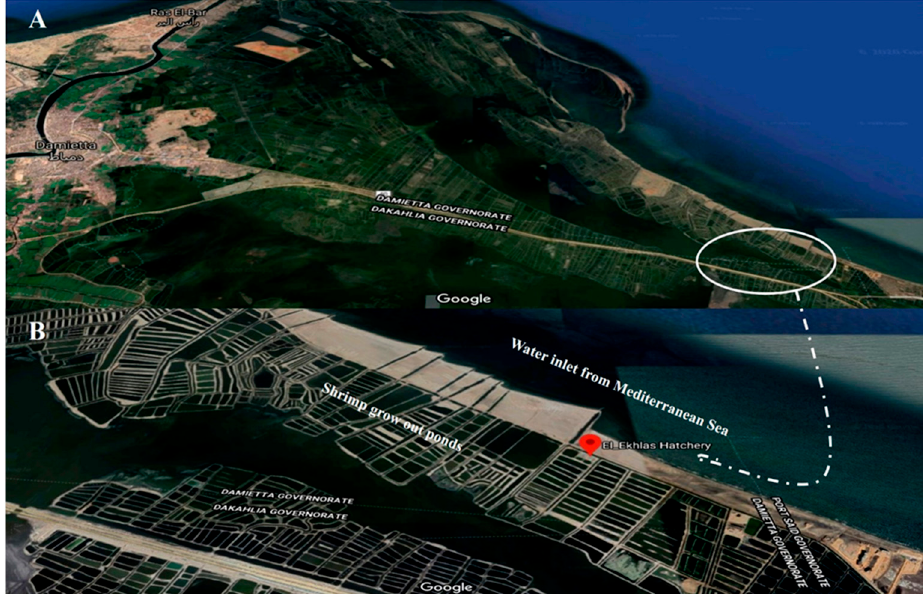
Figure 1. ( A ): Satellite map from Google Earth (https://earth.google.com/web/search/El-Ekhlas+shrimp+hatchery+in+damietta/ (accessed on 3 January 2023)) shows the Dibah Triangle Zone (DTZ), Damietta-Port-Said Province, Egypt. ( B ): El-Ekhlas shrimp hatchery (sampling site) surrounded by shrimp growout ponds.